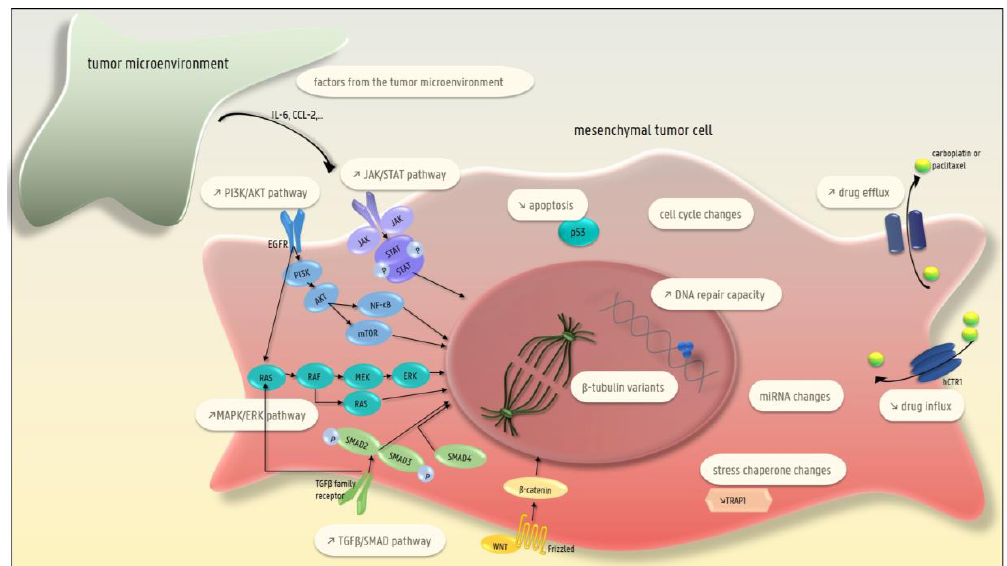
Figure 2. Different EMT-driven mechanisms leading to carboplatin and/or paclitaxel resistance in ovarian cancer cells: the presence of β -tubulin variants; lower drug uptake; higher drug efflux; increased DNA repair capacity; decreased apoptosis; changes in the cell cycle; changes in miRNA; and changes in differen t pathways (MAPK/ERK, TGFβ -SMAD, JAK/STAT, PI3K-AKT- NFκB). In addition, factors secreted by the microenvironment can induce EMT-related therapy resistance.